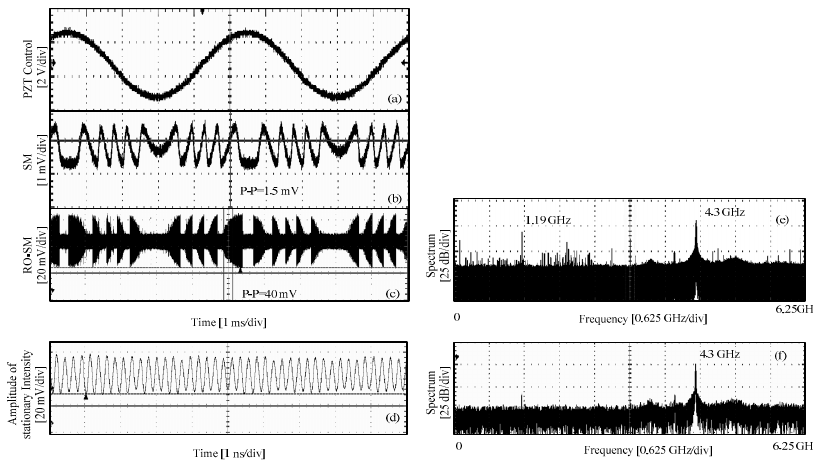
Figure 7. Experimental signals for DL4140-001S. ( a ) PZT control signal; ( b ) conventional SM signals at stable region; ( c ) RO-SM signals at semi-stable region; ( d ) the laser intensity when the target is stationary; ( e , f ) the spectra corresponding to ( c , d ) respectively.